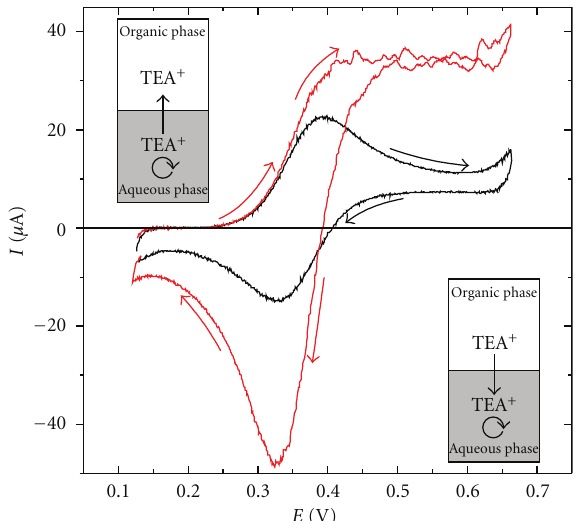
Figure 1: Cyclic voltammograms for the transfer of TEA + . Quies- cent solutions (black line) and aqueous phase agitated at 600 rpm (red line). Organic phase: 1.0 × 10 − 2 M TPADCC. Aqueous phase: KCl 1.0 × 10 − 2 M + 8.0 × 10 − 4 M TEABr. ν = 0 . 025 Vs − 1